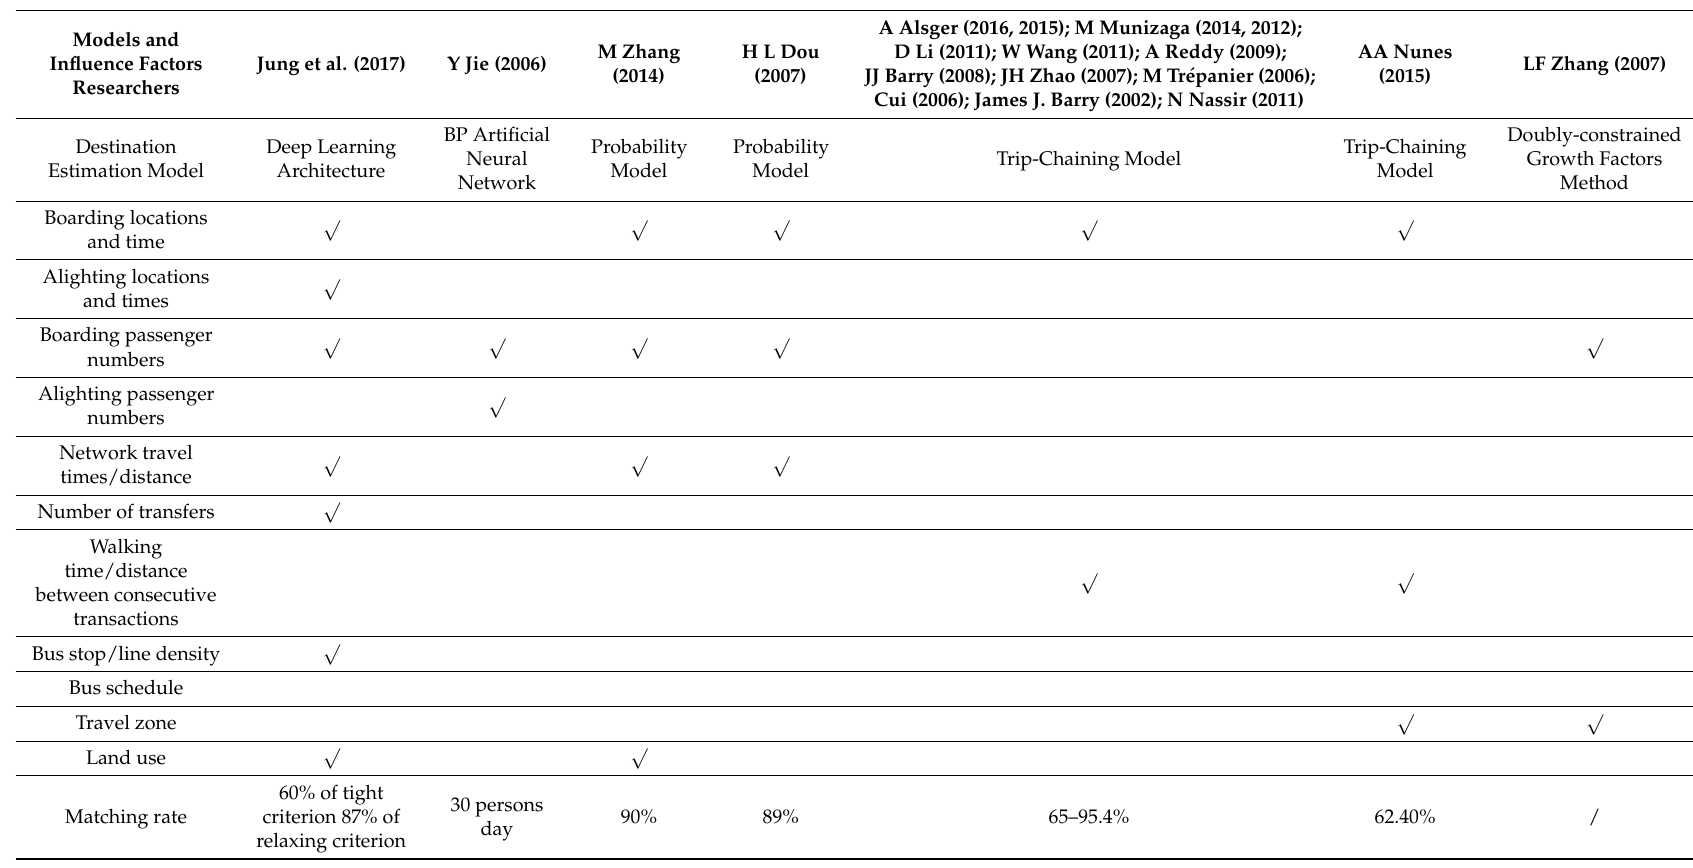
Table 5. Comparison of influence factors in recent